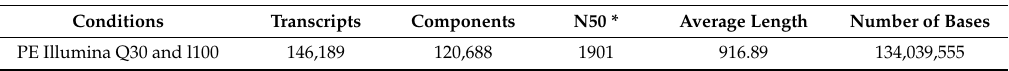
Table 2. De novo transcriptome assembly by Trinity Assembler of ovarian sequencing reads from hāpuku (Polyprion oxygeneios).